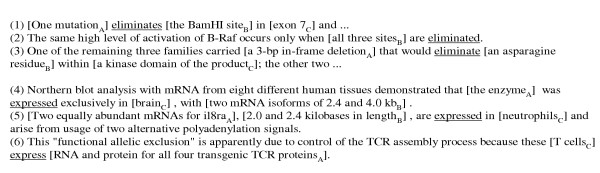
Example of different forms of eliminate and express. Sentences (1)–(3), three different sentences using predicate eliminate taken from MEDLINE [36] and EMBO [37] Journal articles, are given as examples to illustrate the variation of the language usage in biological articles. To convey the information marked as [...A] or [...B] or [...C] can be written in various forms as discussed in the main text. Similarly, the variation of surface linguistic expressions can also be seen from sentences (4)–(6) conveying event express. Sentence (6) is an example to show that the domain knowledge is really necessary for correct understanding.